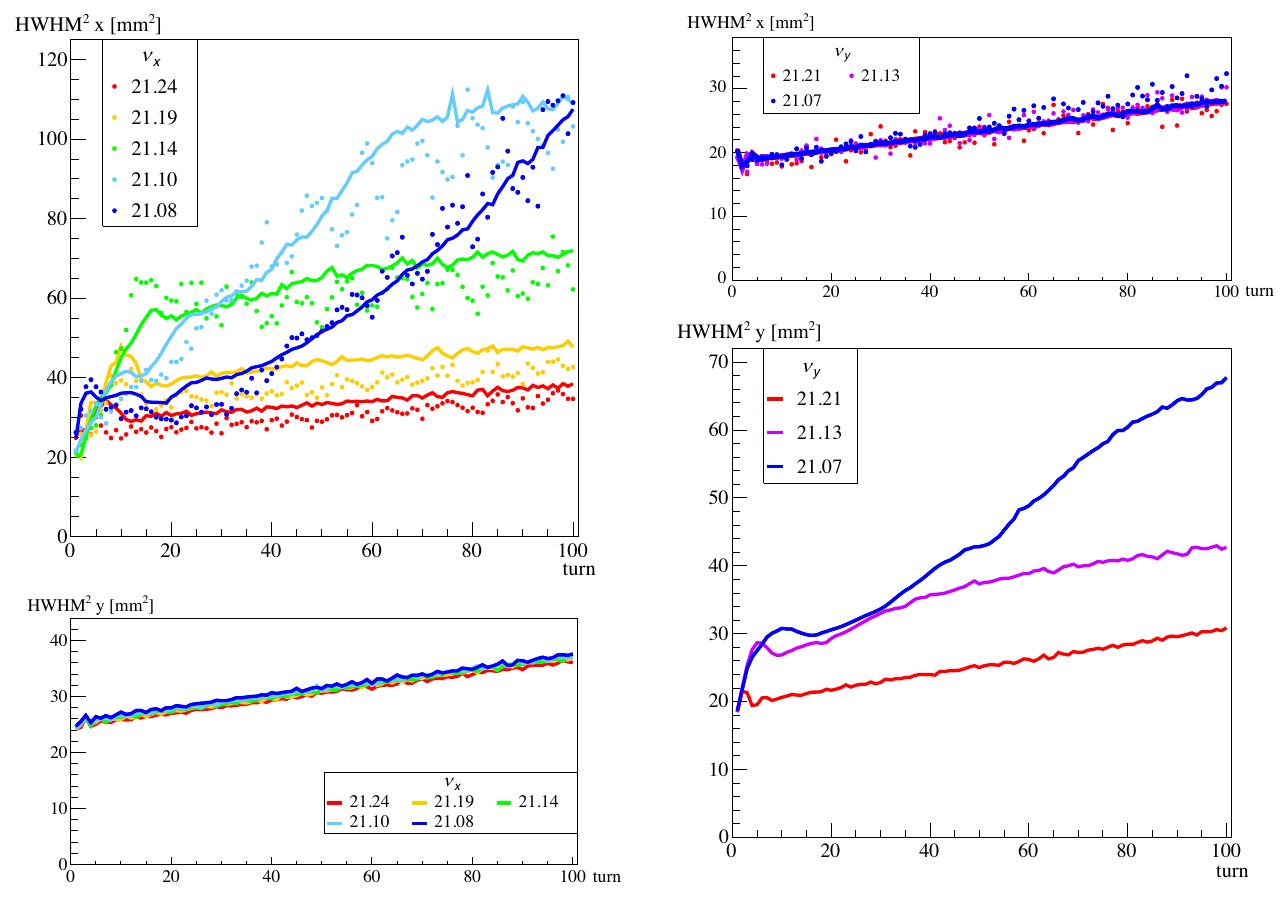
FIG. 6. Beam sizes in the NX21 experiment. The upper picture shows the horizontal beam sizes and the lower picture shows the vertical ones. Experimental results are shown as circles and simulation results are shown as lines. The color difference represents the difference in the horizontal tunes. The vertical tunes were fixed to ν y ¼ 21 . 43 .